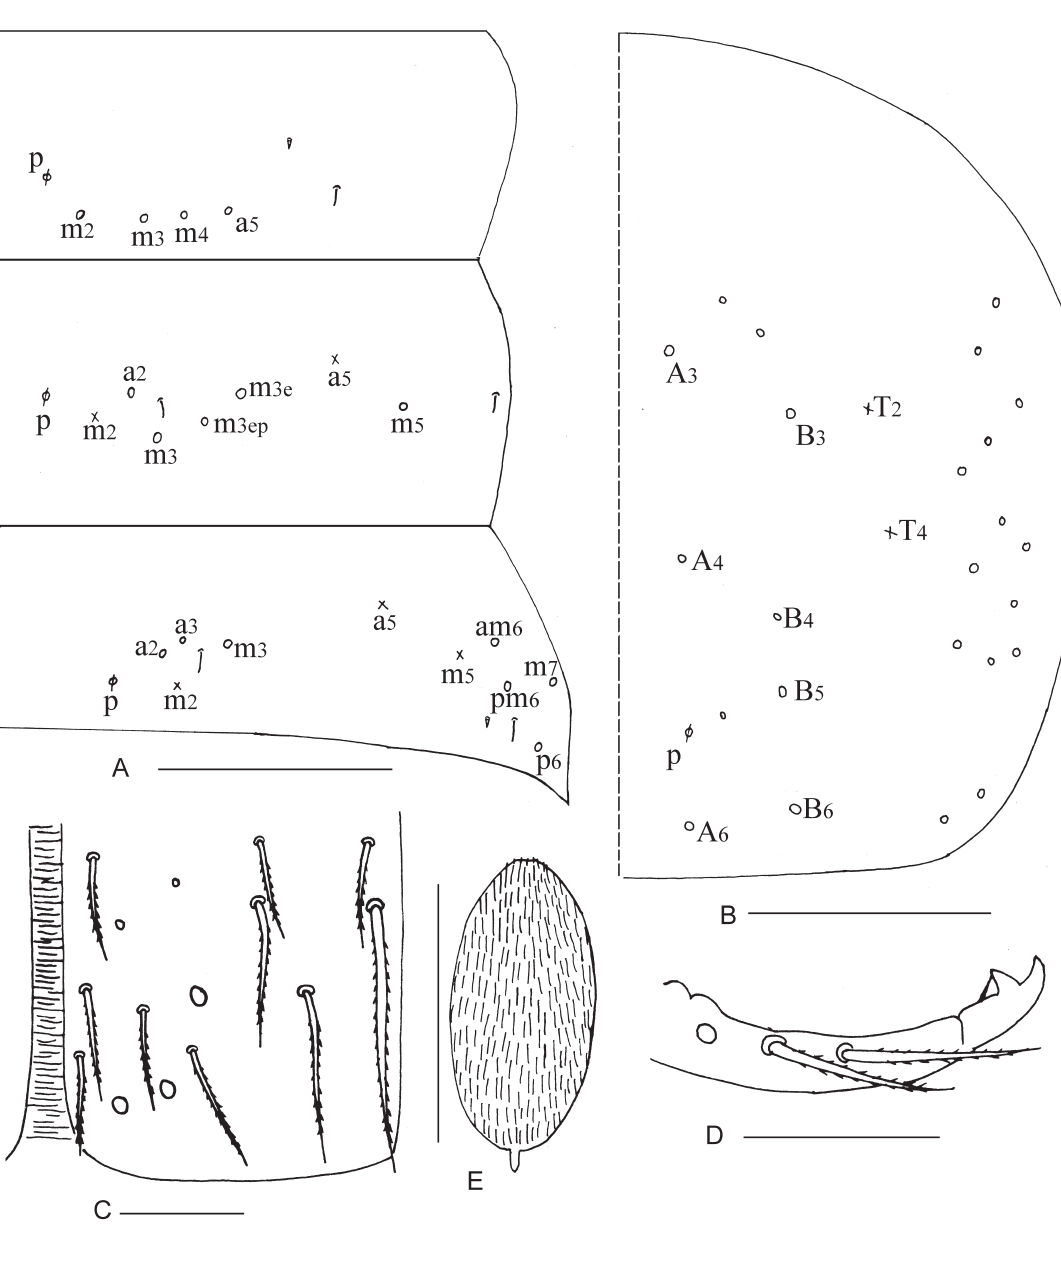
Fig. 7. Willowsia christianseni sp. nov. A . Chaetotaxy of Abd. I−III. B . Chaetotaxy of Abd. IV. C . Anterior face of ventral tube. D . Distal part of dens and mucro. E . Scale. Scale bars: A–B = 100 μm; C−E = 20